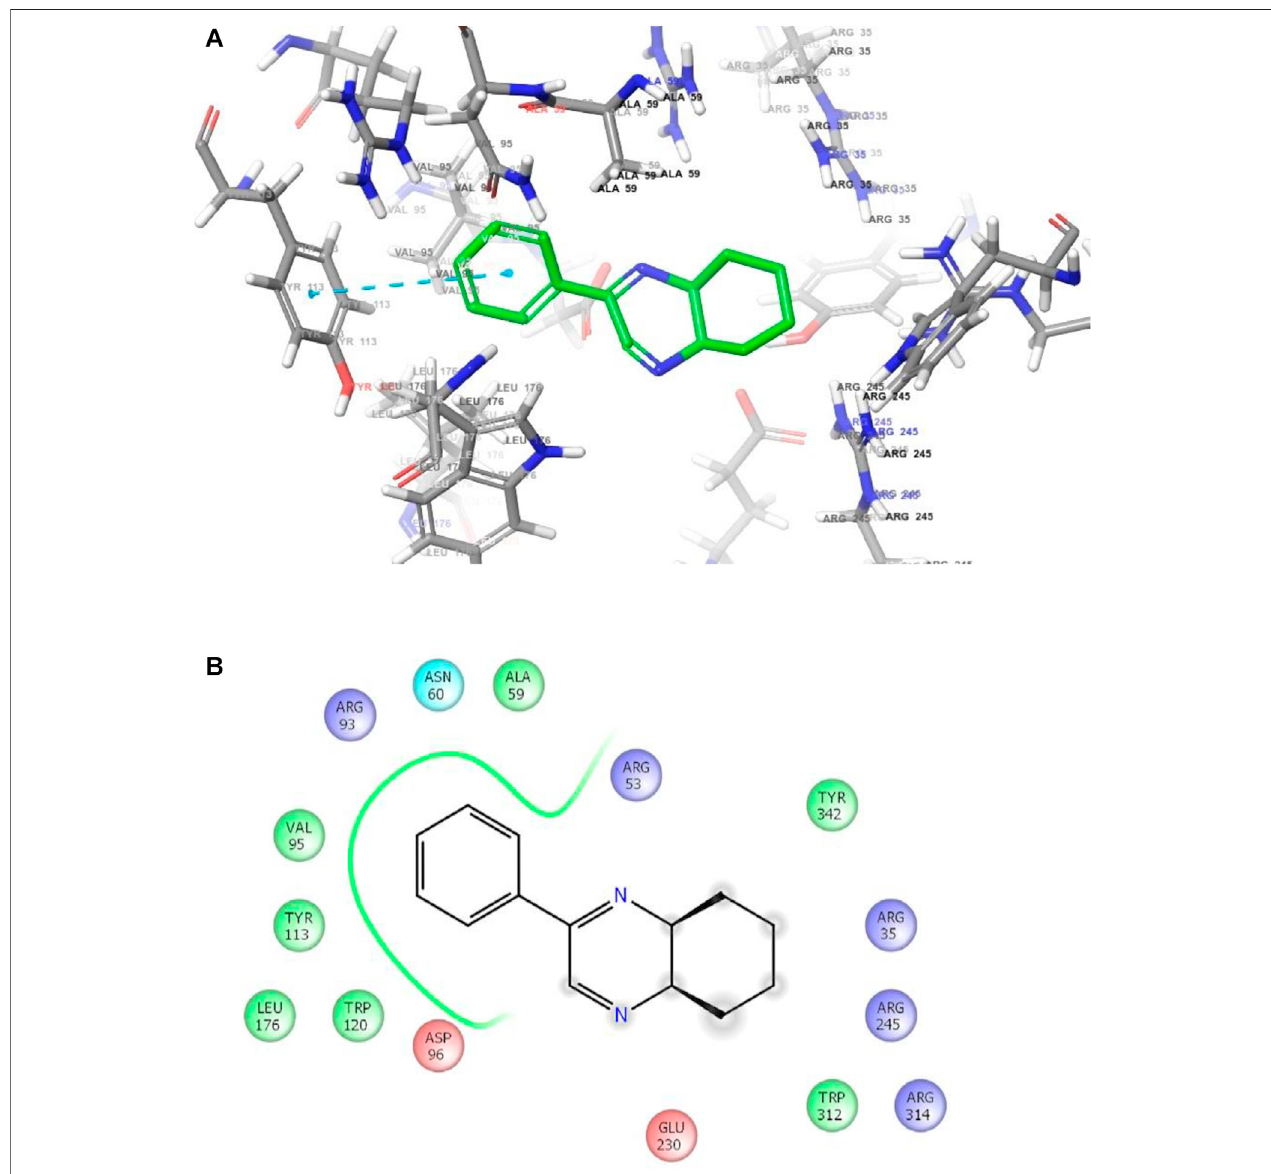
FIGURE3|(A) Thebindingmodeoftheinteractionsbetween 1 with T.cruzitrans -sialidase(PDBID:1S0J). (B) Resultsofthevalidationof 1 insidethe T.cruzitrans - sialidase active sites.